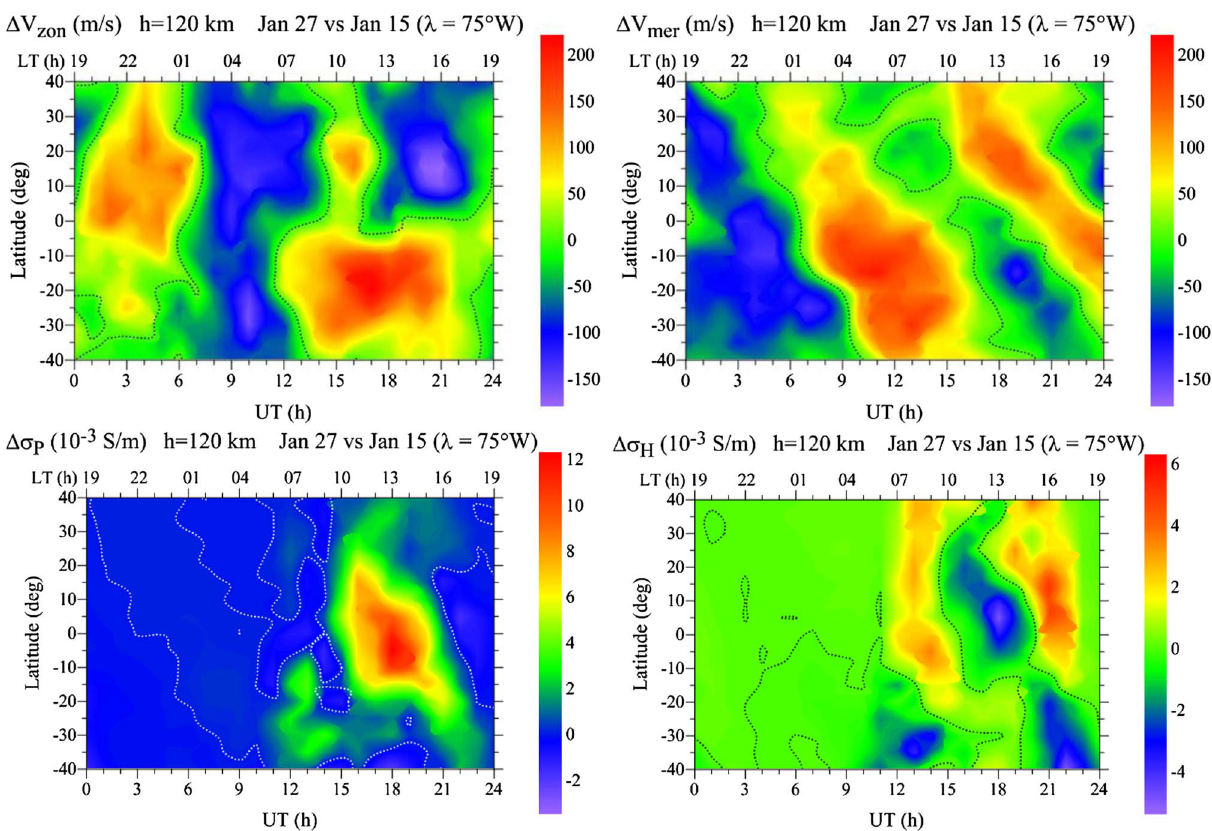
Fig. 5. EAGLE-simulated diurnal variations of the disturbances in zonal and meridional thermospheric wind (top panels) and Pedersen and Hall conductivities (bottom panels) on 27 January 2009 at the latitude range from 40 (cid:3) S to 40 (cid:3) N in the American longitudinal sector (75 (cid:3) W) and 120 km